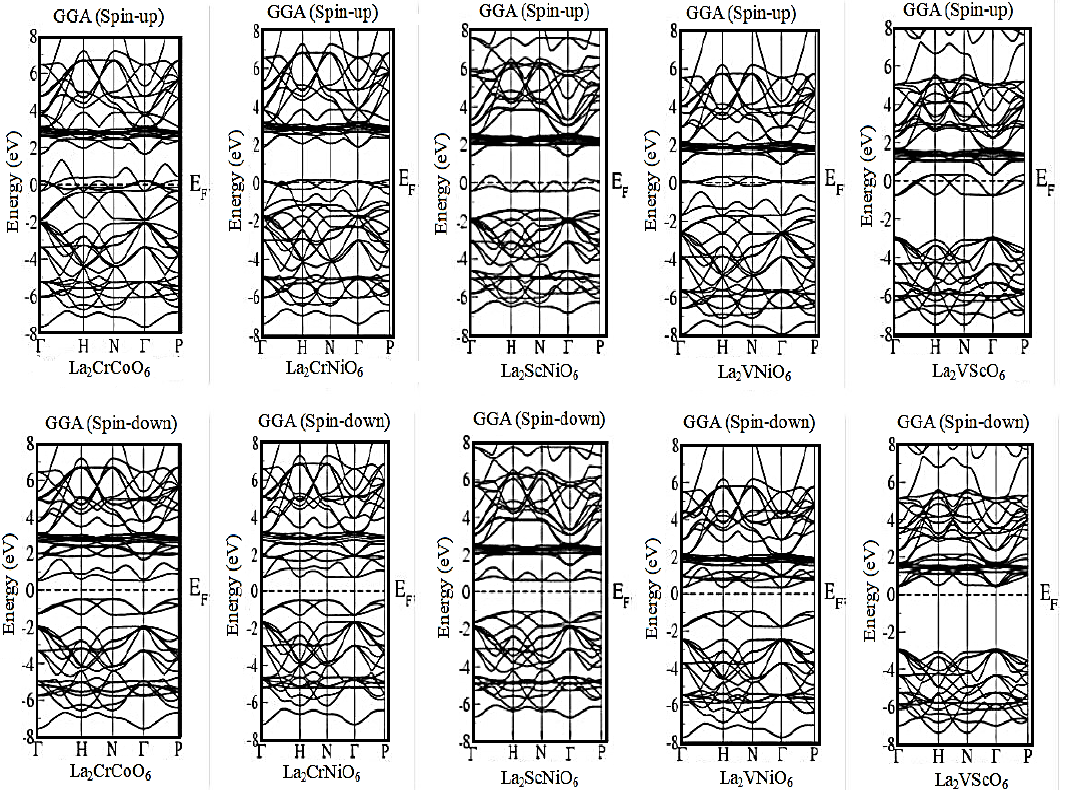
Crystals 2022 , 12 , x FOR PEER REVIEW Figure 2. Band structures of DPC La 2 BB ′ O 6 using GGA in both spin ‐ up and spin ‐ down channels. Figure 2. Band structures of DPC La 2 BB (cid:48) O 6 using GGA in both spin-up and spin-down channels.